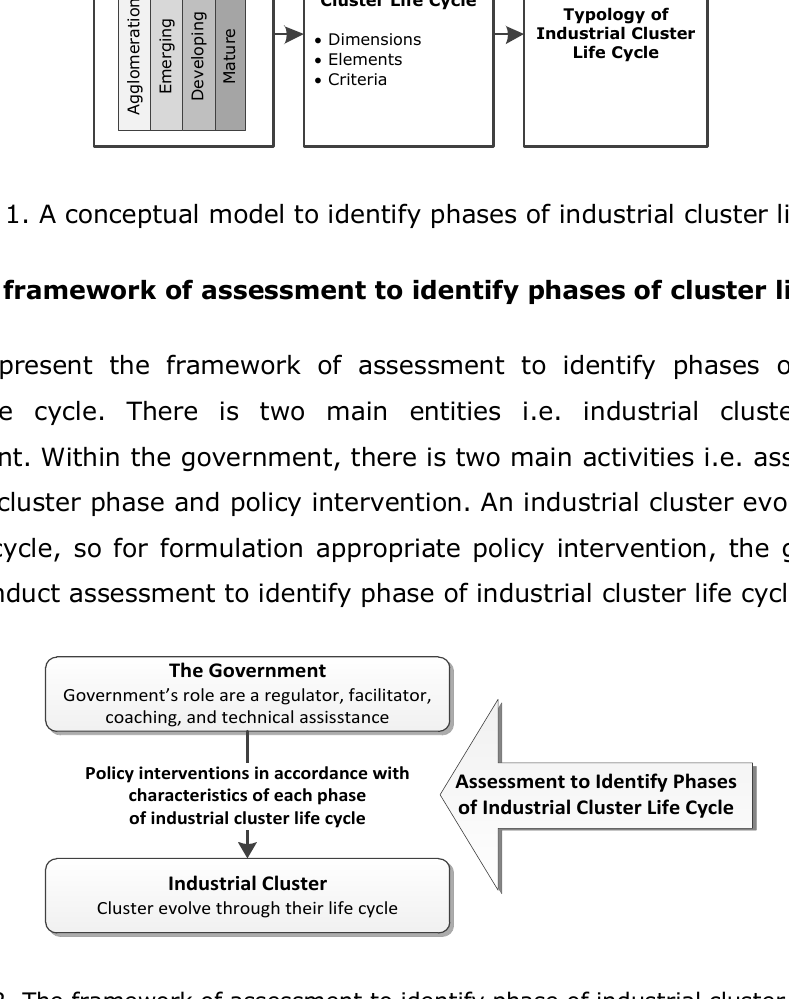
Figure 2. The framework of assessment to identify phase of industrial cluster life